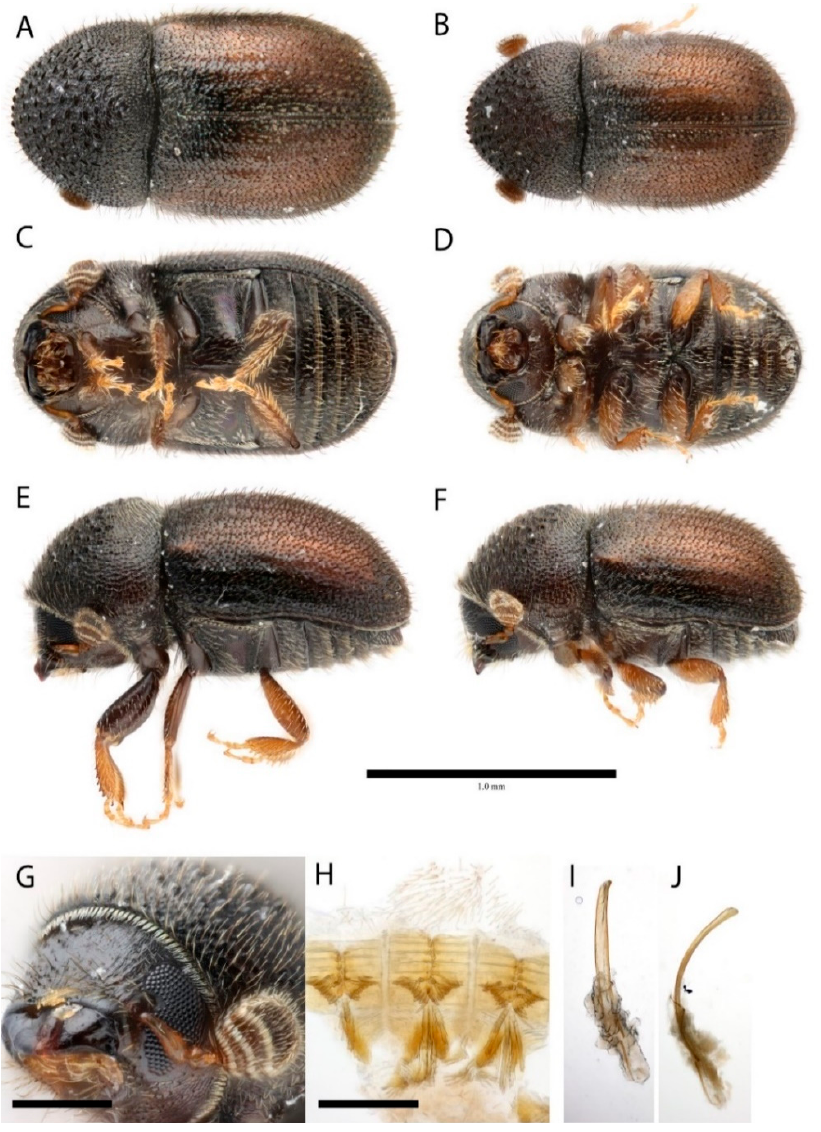
Figure 1. Images of Cryphalus eriobotryae . ( A , B ) Dorsal view; ( C , D ) ventral view; ( E , F ) lateral view; ( G ) head; ( H ) proventriculus; ( I , J ) male genitalia; ( A , C , E , G ) holotype (female); ( B , D , F , H , I , J ) paratype (male). Images courtesy of Andrew Johnson, UF Forest Entomology Collection, (CC BY 3.0).